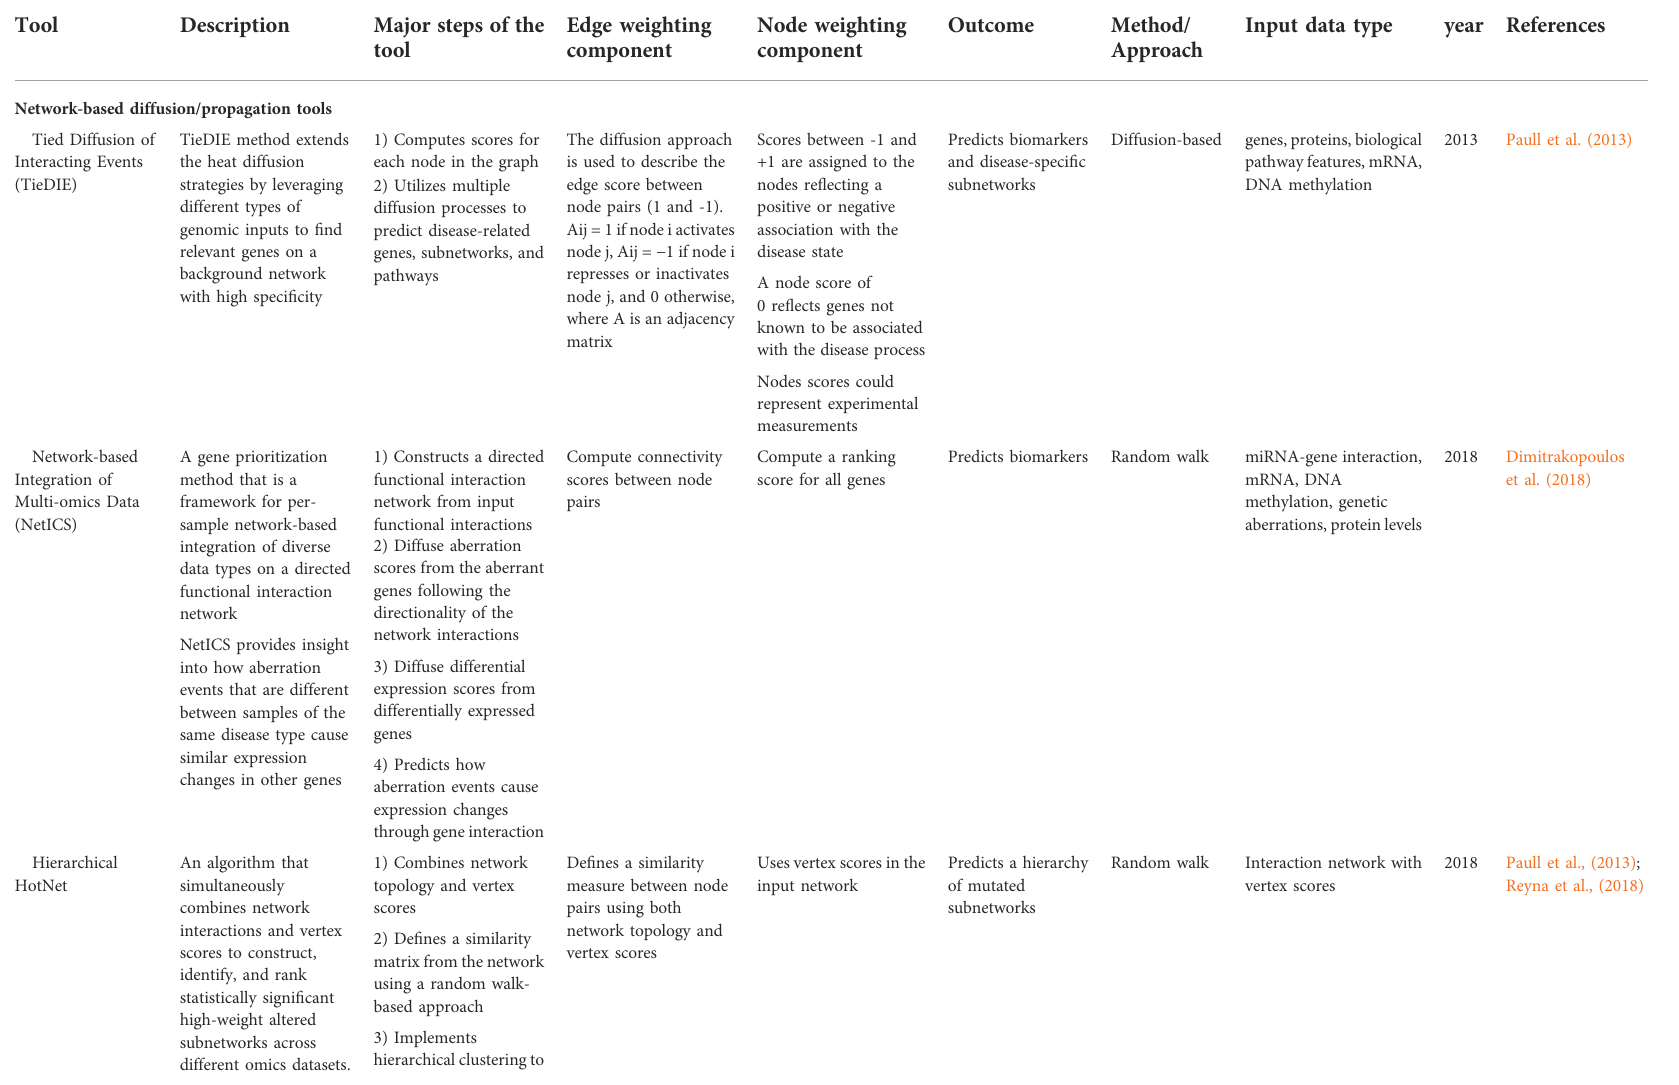
TABLE 1 ( Continued ) Network-based multi-omics integrative tools for predicting biomarkers, crosstalk, disease subtypes, and subnetworks/enriched